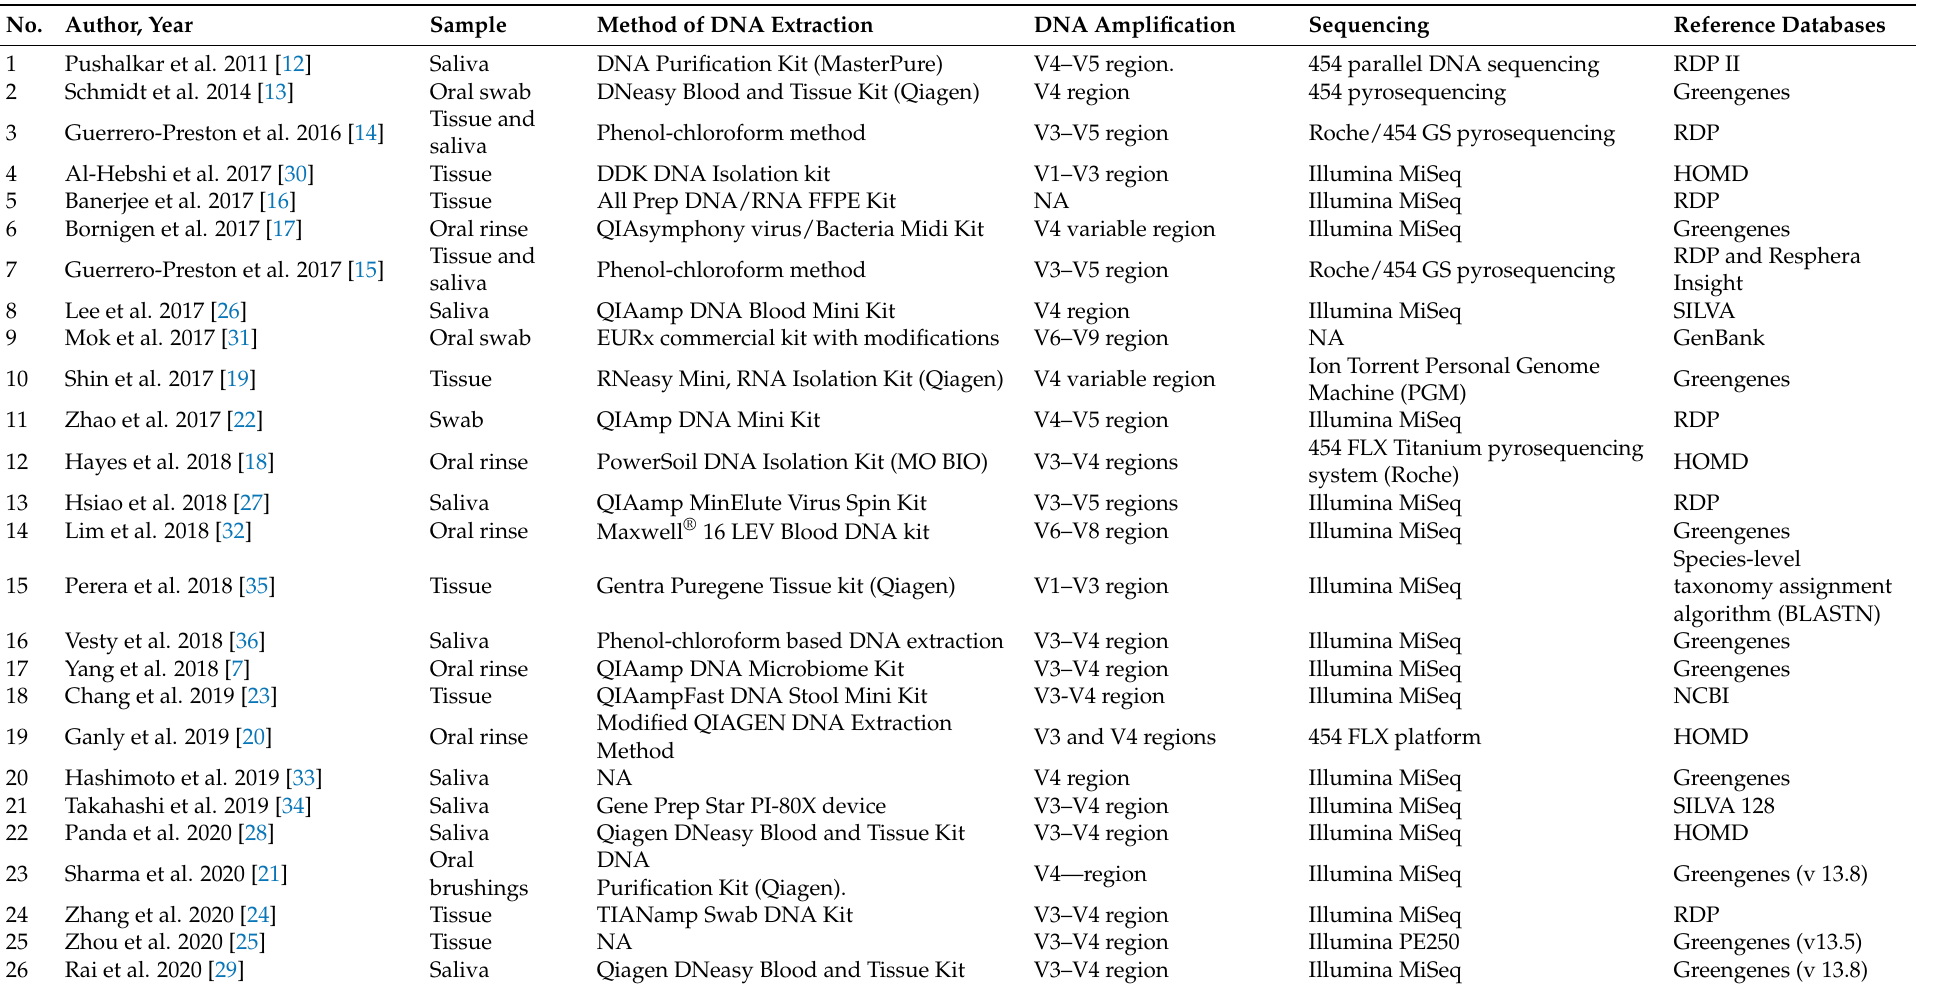
Table 2. Summary of techniques of DNA extraction, amplification, and sequencing, and reference